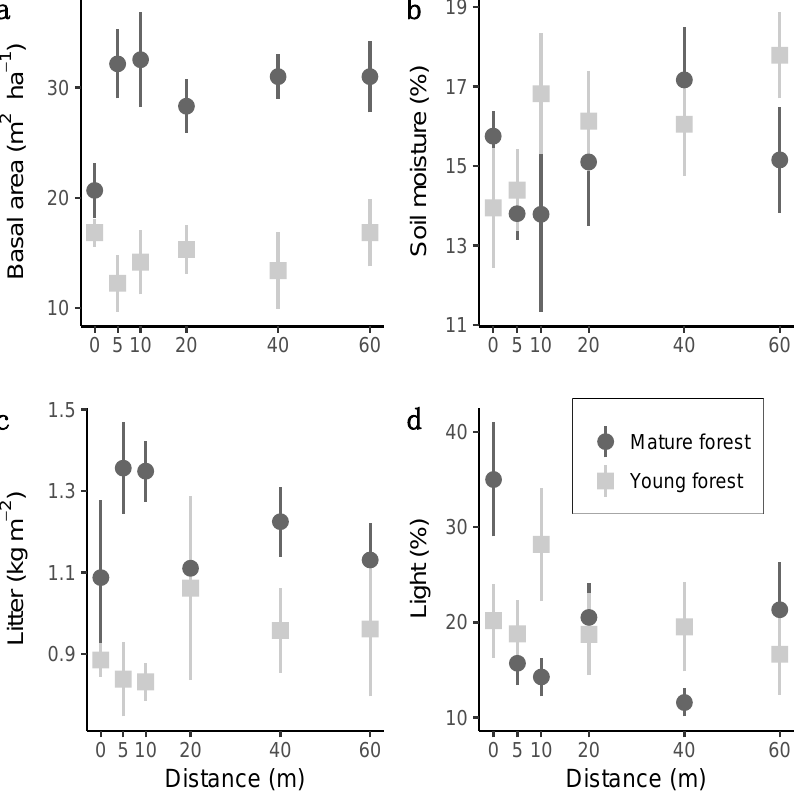
Figure 1. The mean and standard error of the forest structure and environmental variables measured at each distance at each site. ( a ) Basal area, ( b ) soil moisture, ( c ) litter mass, ( d ) light availability.